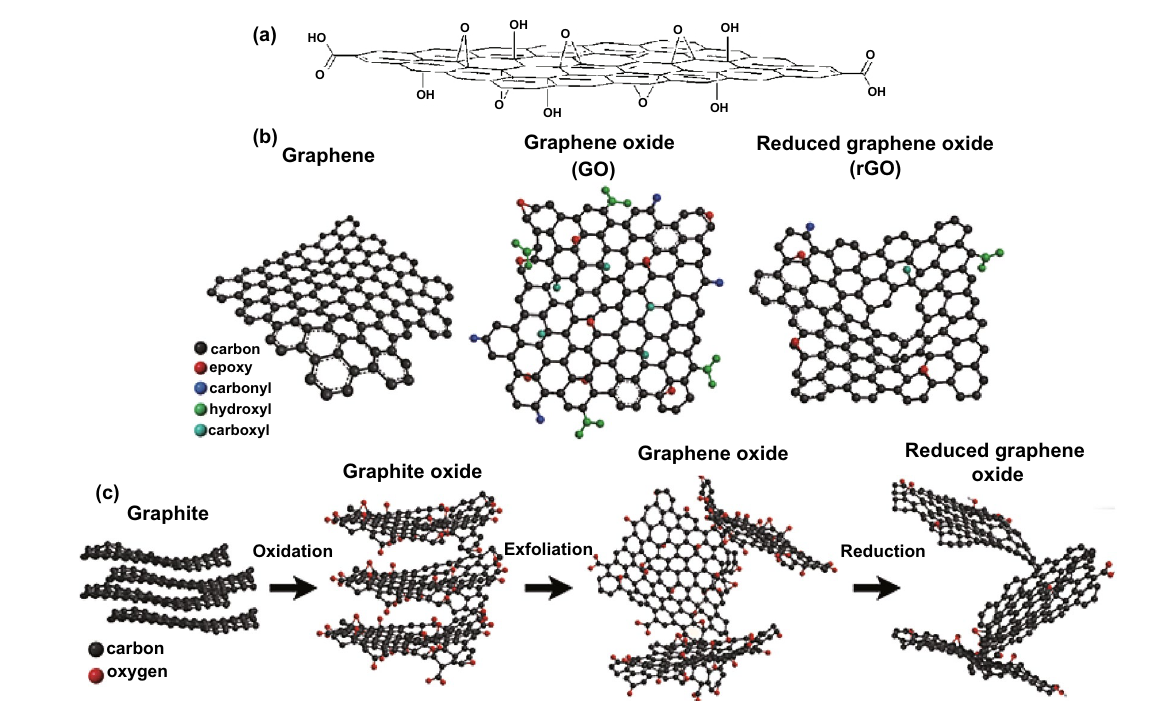
Fig. 4 a Schematic model of GO basal–center–edge planes oxygen–containing functional groups. Reproduced with permission from Ref. [75] Copyright © 2008, American Chemical Society. b Schematic view of the graphene, graphene oxide, and reduced graphene oxide chemical struc- tures. c Synthesized routes of graphite to graphene oxide and reduced graphene oxide. Reproduced with permission from Ref. [14] Copyright © 2016, Intech